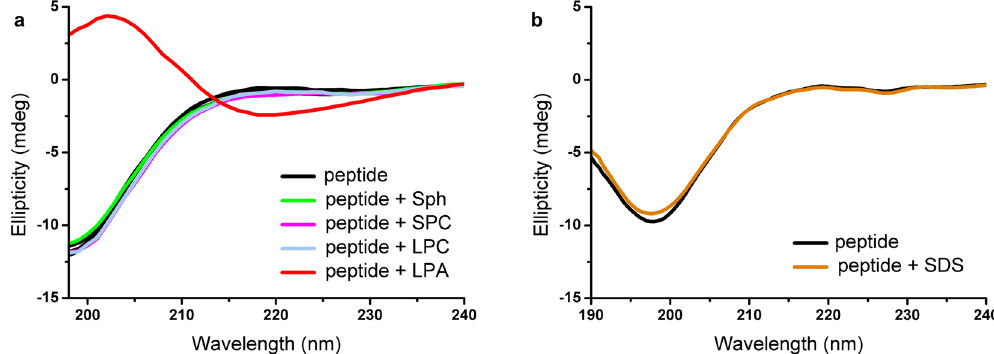
Figure 3. LPA selectivity among the investigated peptide-lipid interactions. CD spectra for GAP43pIQ (36 µ M) were measured in the presence and absence of lysophospholipids (lysophosphatidylcholine, LPC, sphingosylphosphorylcholine, SPC, and sphingosine, Sph) at 100 µ M in high-salt buffer ( a ), and SDS at 100 μ M in low-salt buffer ( b ), respectively. Only LPA affected peptide